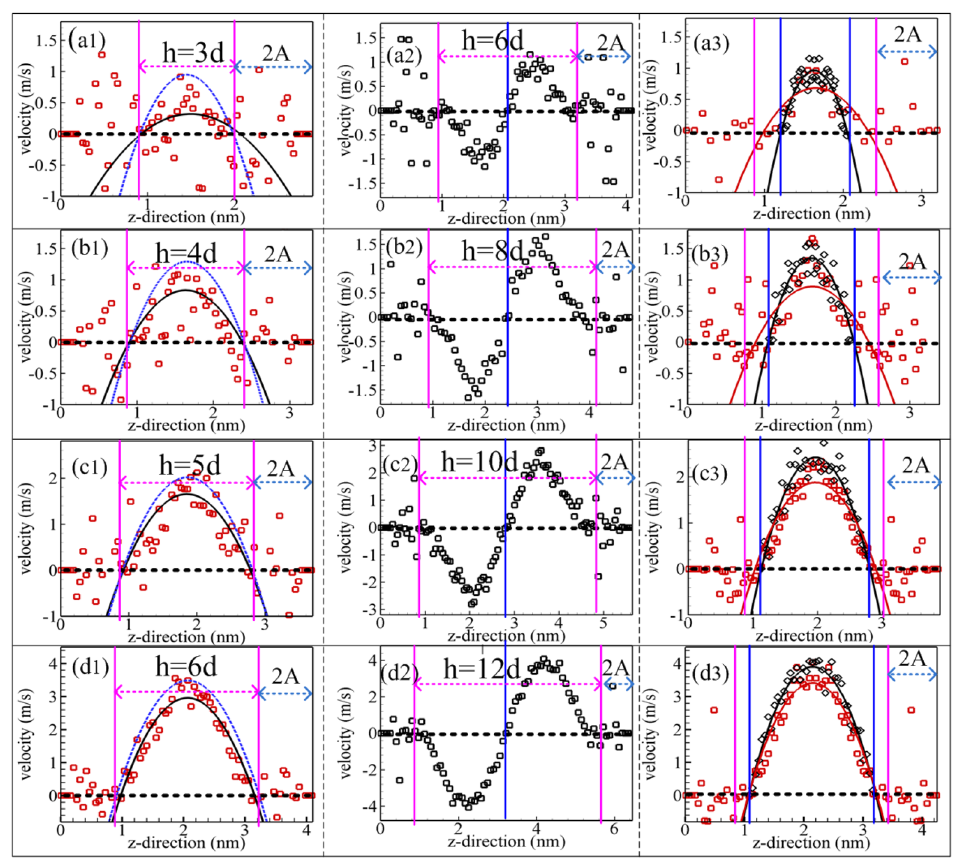
Figure 2. The average velocity profiles (red or black square) are calculated by using the NEMSMD simulations, the red and black solid lines are fitted by the simple points fitting simple points inside the nanochannel, and blue Dash line indicates the analytical results from the Poiseuille flow with the nonslip boundary. Meantime, blue and pink perpendicular lines denote rough and non-slip boundary,